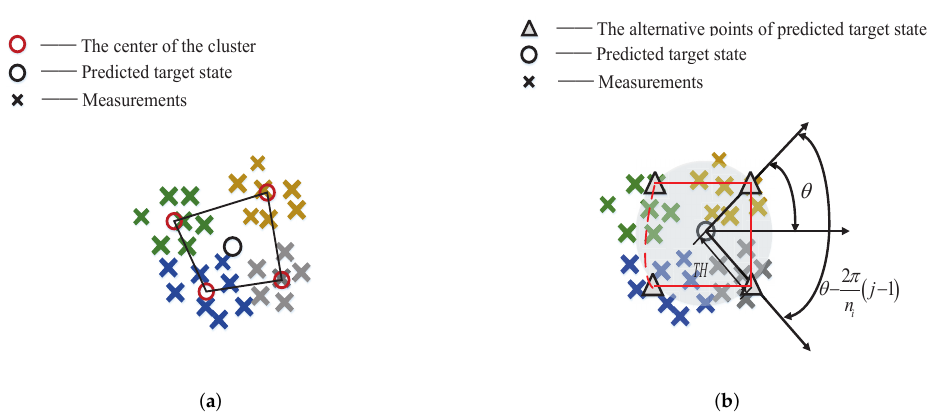
Figure 1. The measurement distribution in unreasonable subset. ( a ) The geometrical distribution of the target prediction and the centers of 4 clusters. ( b ) The selection of alternative points in prediction-driven measurement sub-partitioning (PMS)